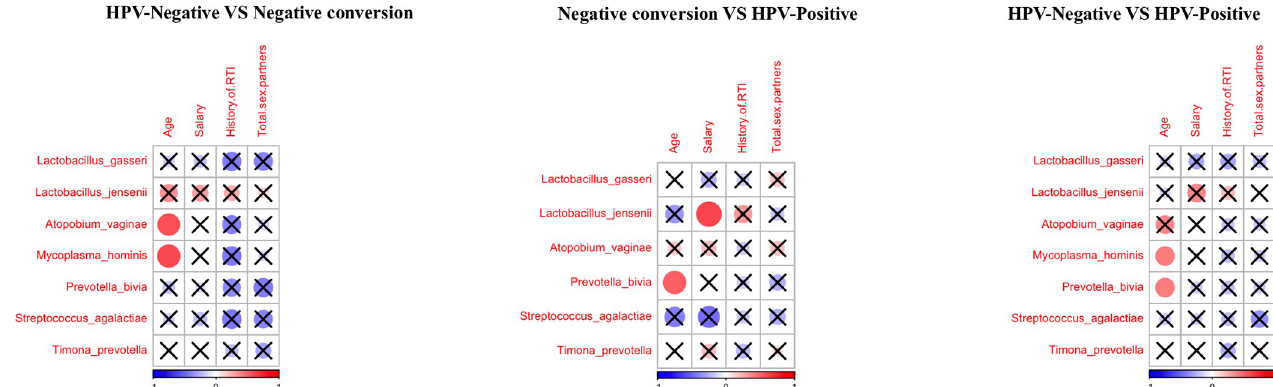
Fig 5. Association between personal indicators the candidate biomarkers. Legend: Correlation coefficients between four potential biomarkers and personal indicators in HPV-negative vs negative-conversion, negative-conversion vs HPV-positive, and HPV-negative vs HPV-positive cohorts. Red and blue represent positive and negative associations. Crosses represent no significant correlation (p-value > 0.05). The size of the circle represents the R-value of the personal factors and the microorganisms calculated from the linear regression.